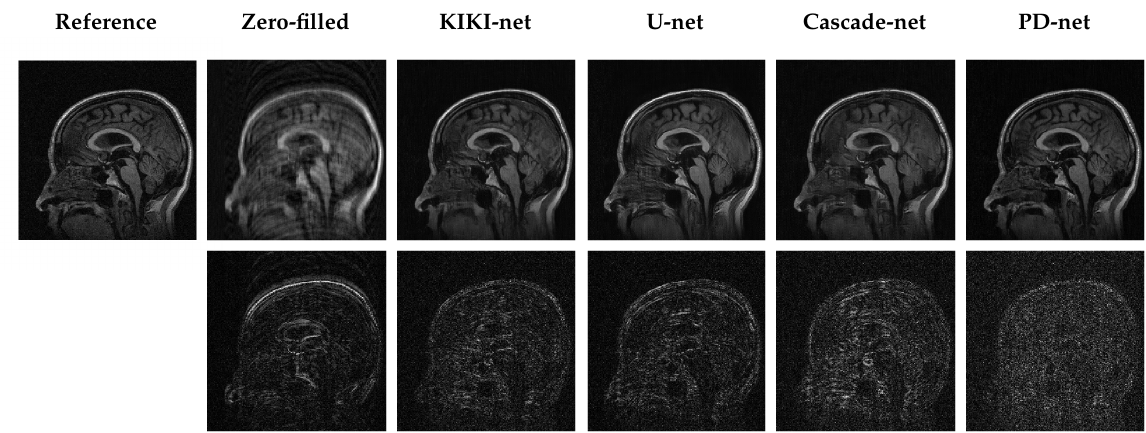
Figure 7. Reconstruction results for a specific slice (15th slice of sub-OAS30367_ses-d3396_T1w.nii.gz , part of the validation set). The top row represents the reconstruction using the different methods, while the bottom row represents the absolute error when compared to the